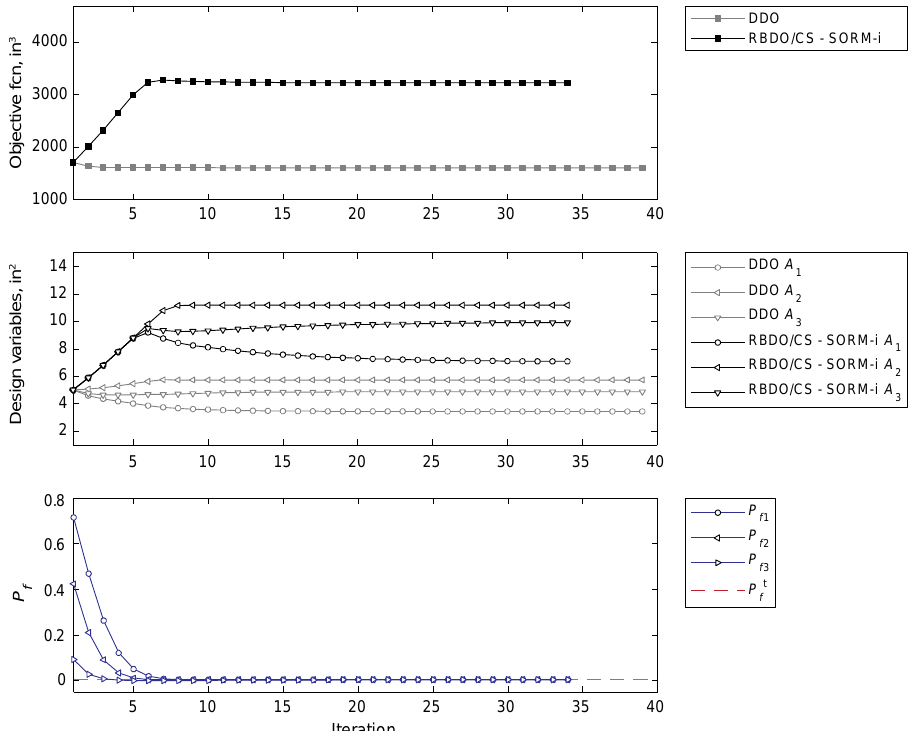
Figure 5. Convergence history of the objective function and design variables pertaining to the deterministic design optimization (DDO) and RBDO/CS – SORM-i, and failure probabilities obtained using the RBDO/CS – SORM-i framework.